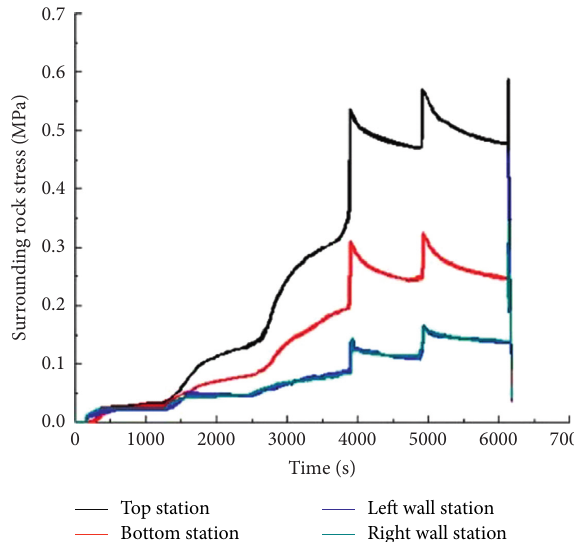
Figure 21: Surrounding rock stress variation curve with time.